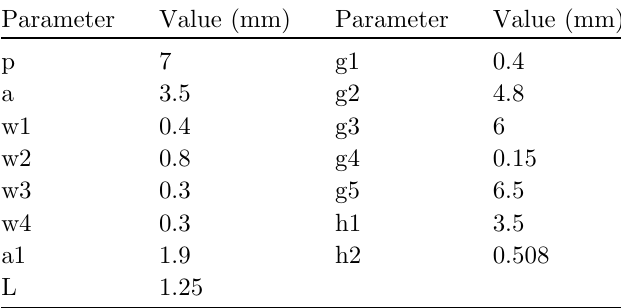
Table 1. Parameters of the proposed